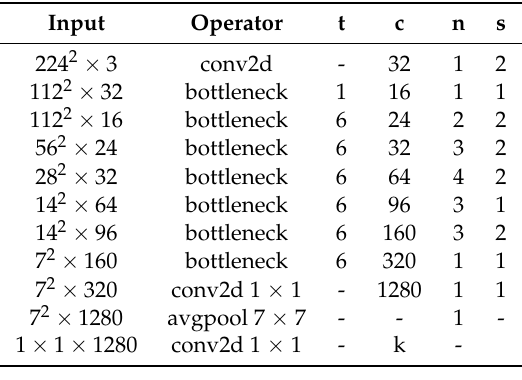
Table 4. MobileNetV2 : Each line describes a sequence of 1 or more identical (modulo stride) layers, repeated n times. All layers in the same sequence have the same number c of output channels. The first layer of each sequence has a stride s and all others use stride 1. All spatial convolutions use 3 × 3 kernels [51].